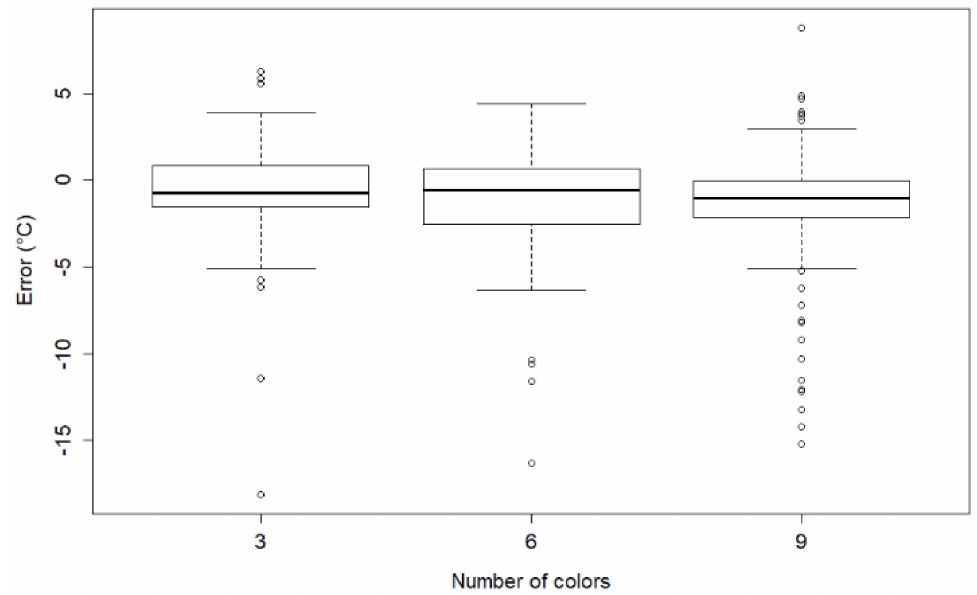
Figure 10. Spread of error according to the number of